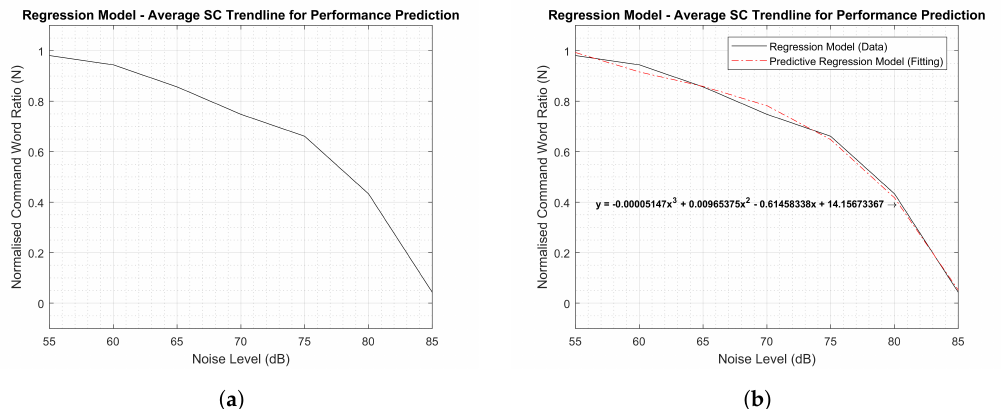
Figure 8. Modelling the SC trendline. ( a ) SC trendline model—normalised, ( b ) SC trendline predictive model